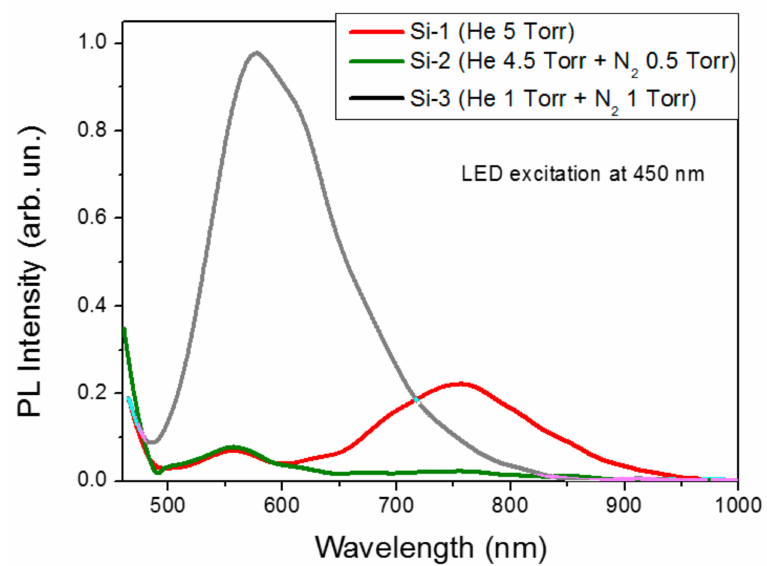
Figure 5. Photoluminescence spectra of laser-ablated Si films prepared under di ff erent gas mixtures: 5 Torr He (red); 4.5 Torr He + 0.5 Torr N 2 (green); 1 Torr He + 1 Torr N 2 (black). Such a supposition on the origin of “red” and “green-yellow” PL bands was confirmed by measurements of PL transients under the excitation by 20 ns laser (wavelength 351 nm). As shown